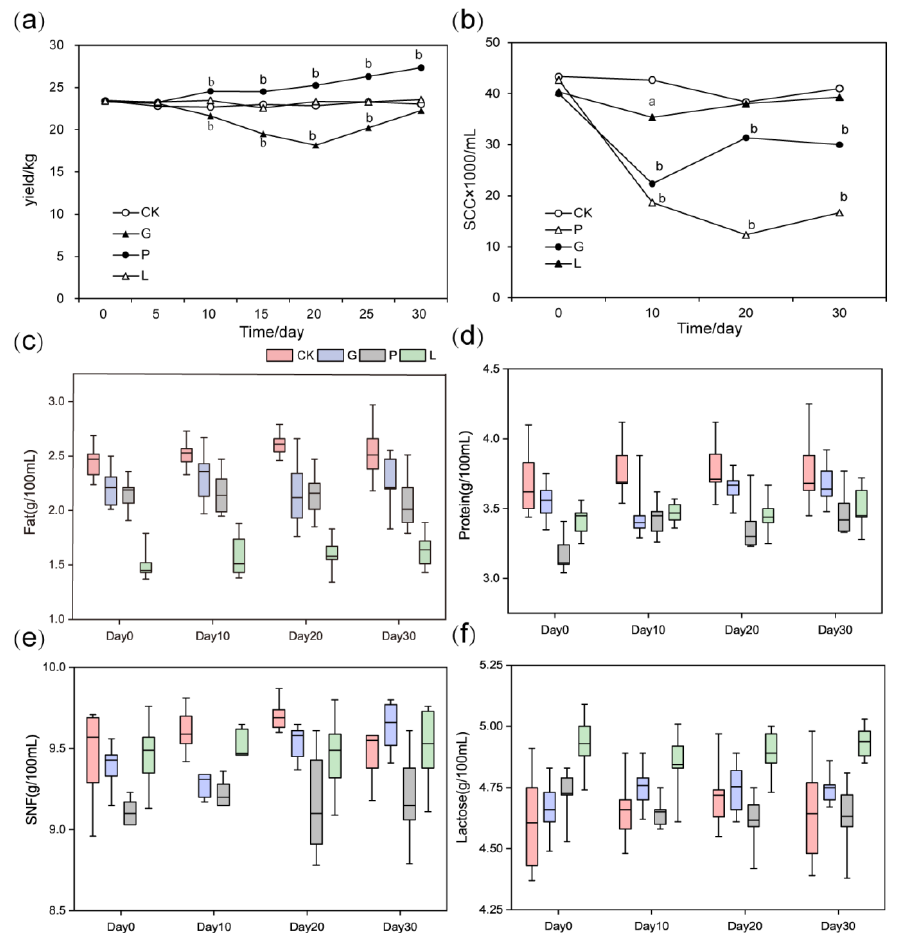
Figure 1. Effects of different microbial treatments on milk production ( a ), SCC ( b ) and milk quality. ( c ) Fat content in milk, ( d ) Protein content in milk, ( e ) SNF content in milk, ( f ) Lactose content in milk. a: Compared with the control group, p < 0.05, b: Compared with the control group, p < 0.01.